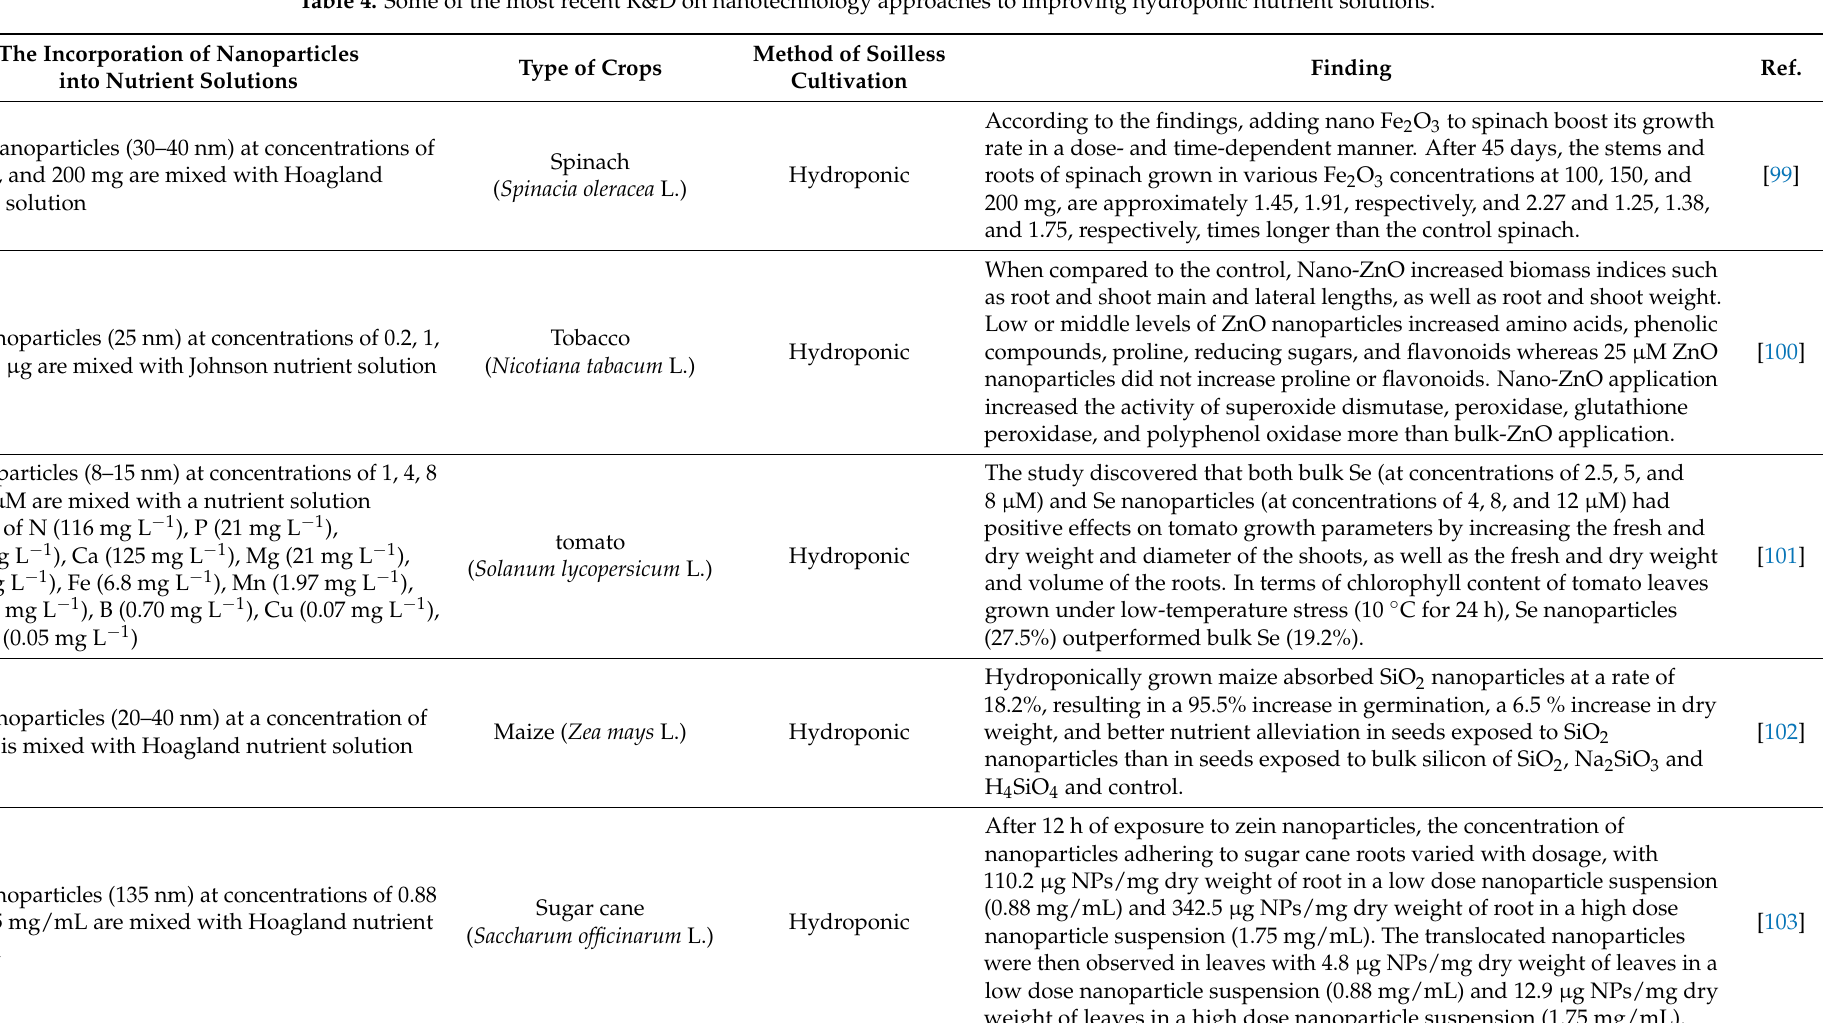
Table 4. Some of the most recent R&D on nanotechnology approaches to improving hydroponic nutrient